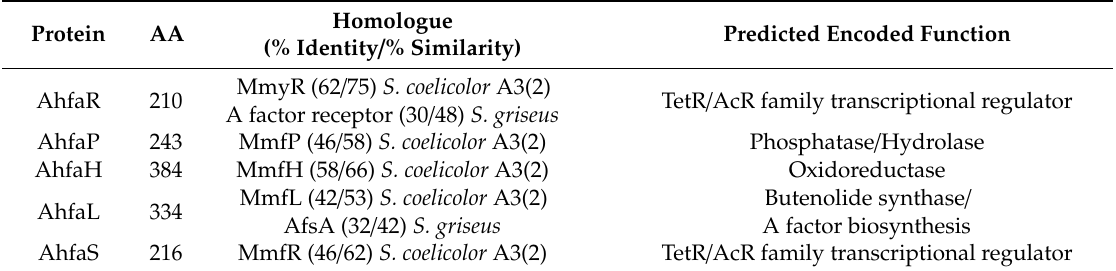
Table 2. Deduced functions of open reading frames (ORFs) in ahfa biosynthetic gene cluster.